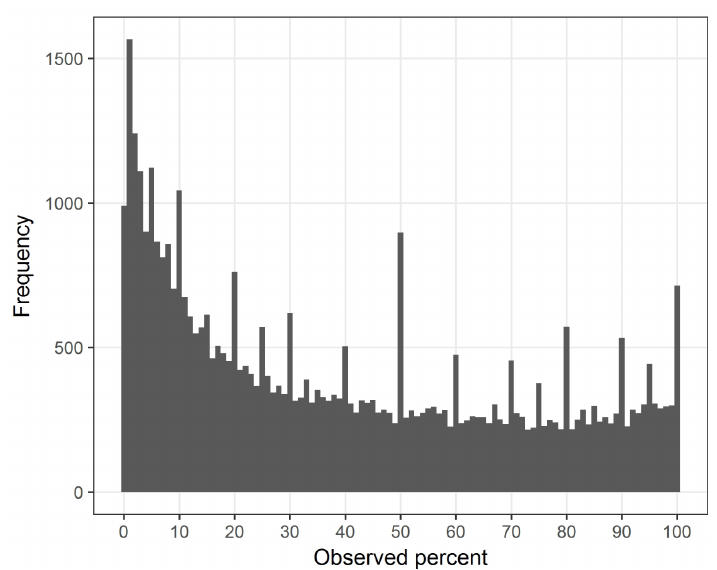
Figure 2. Histogram of all percents between 0% and 100% in 1%